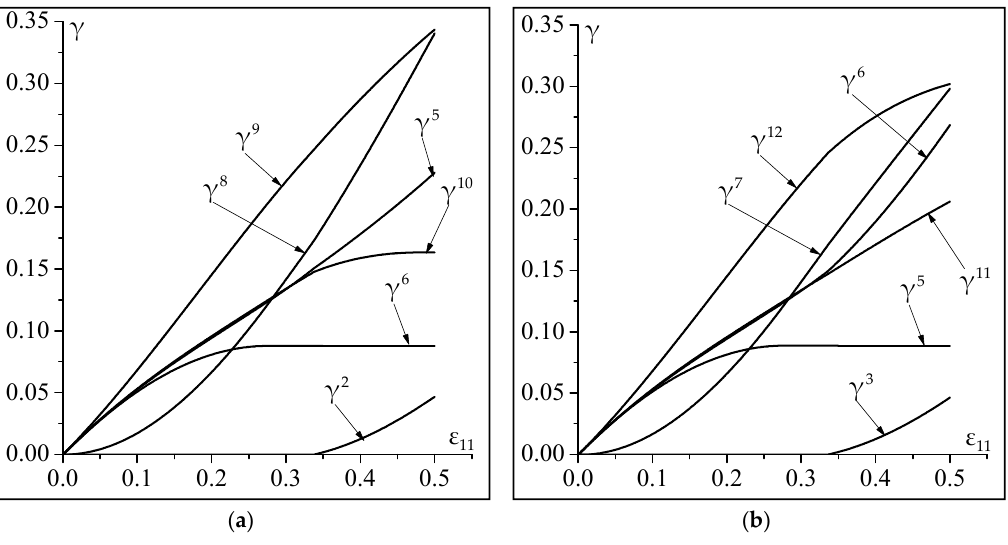
Figure 2. Significance of the non-Schmid effects on the slip system activity: ( a ) Results without non-Schmid effects (a 1 = a 2 = a 3 = 0); ( b ) Results with non-Schmid effects (a 1 = 0.2;a 2 = a 3 =